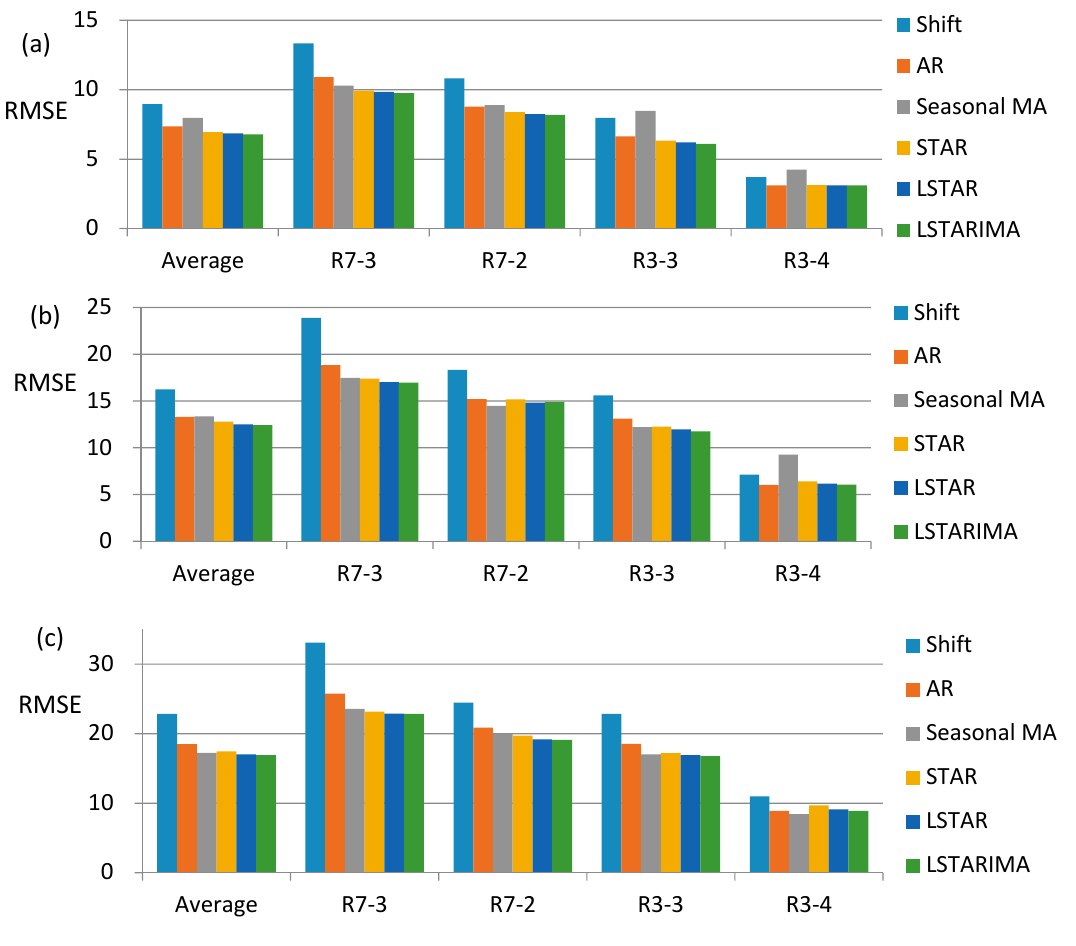
Figure 4. Prediction accuracy comparison of different models with: ( a ) 5-min prediction interval; ( b ) 15-min prediction interval; and ( c ) 30-min prediction interval.